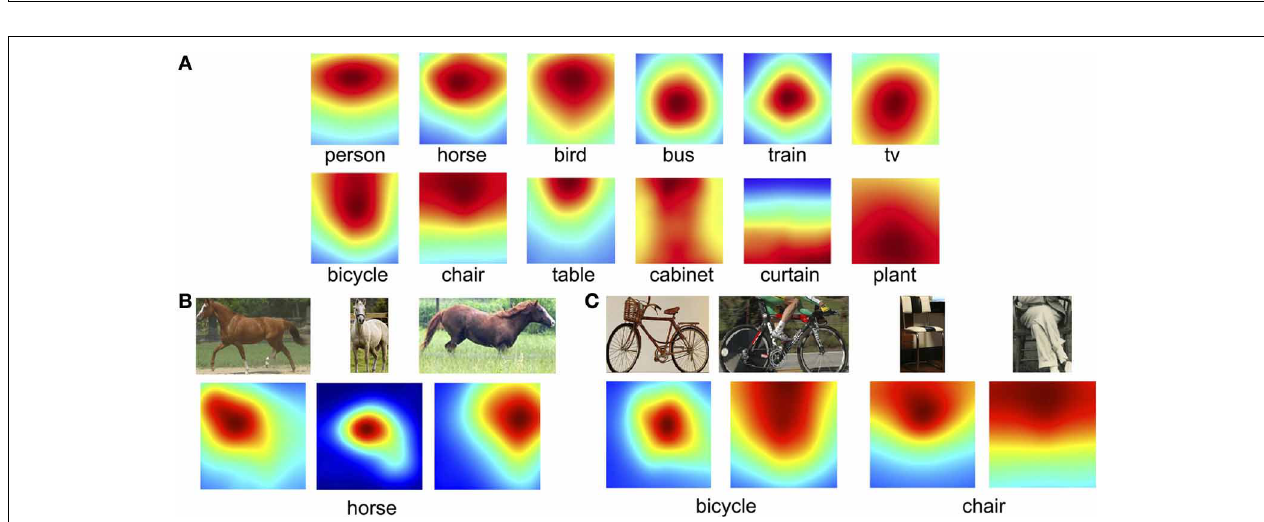
FIGURE 6 | Average fixation density maps for select object categories. (A) Examples showing the category dependent nature of fixation patterns. (B) Representative samples of a face fixation bias, shown here for horses.